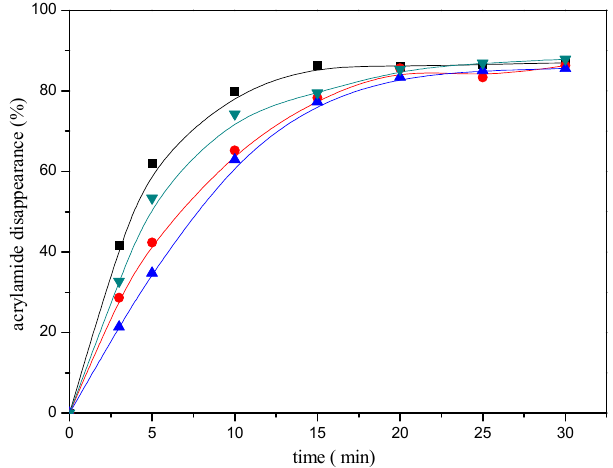
Figure 2. Time-response effect of selected mercaptans on the acrylamide disappearance after heating an acrylamide (0.2 μ mol)/mercaptans (20 μ mol) model system at 180 °C and pH 7. Mercaptans assayed were 1,2-ethanedithiol ( ■ ), 2-methyl-3-furanthiol ( ▼ ), 1-butanethiol ( ● ), and 2-furanmethanethiol ( ▲ ).